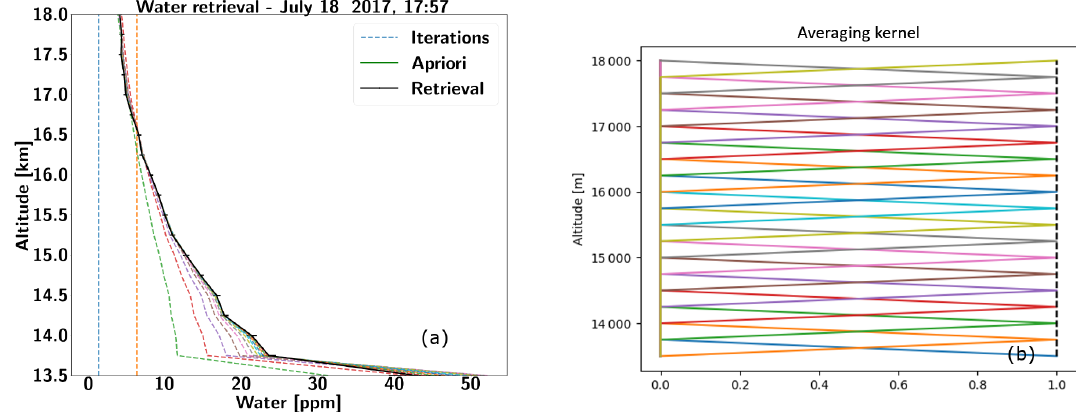
Figure 18. Example SHOW water vapour retrieval (a) and the associated averaging kernel (b) .